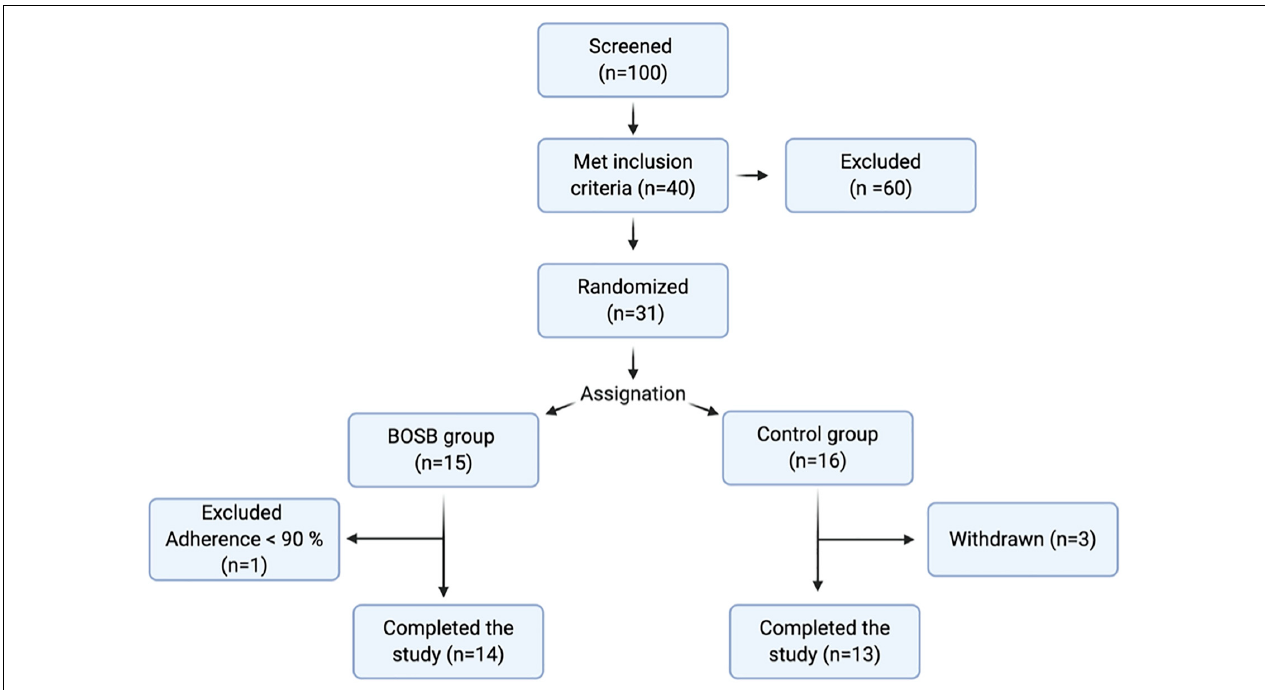
FIGURE 1 | Study design. Flow chart for overall screening